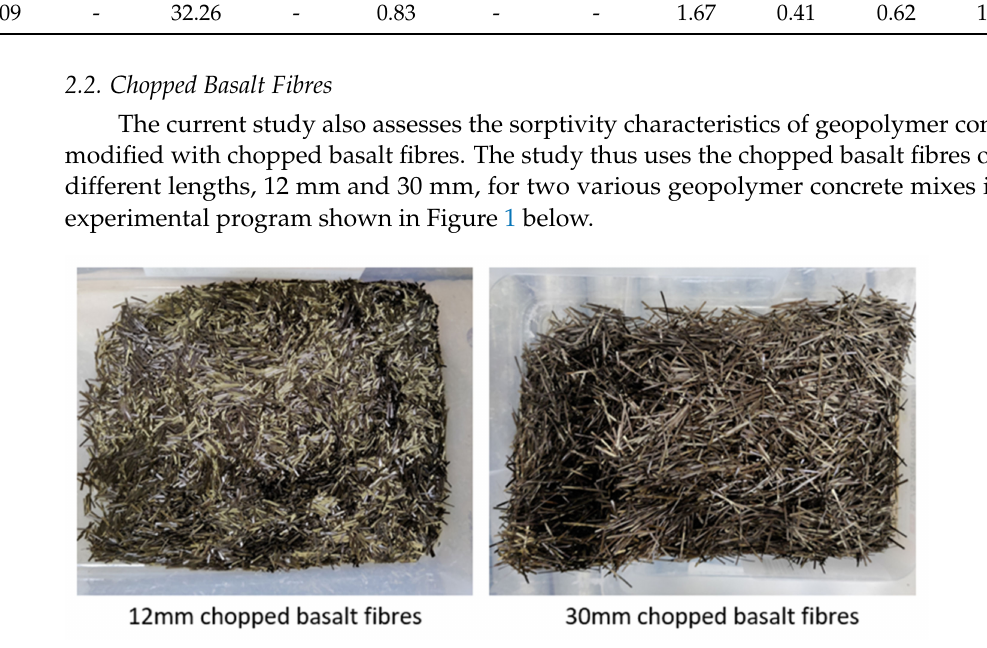
Figure 1. Images of 12 mm and 30 mm chopped basalt